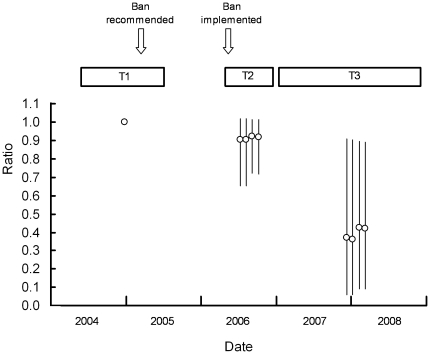
Changes in the expected rate of decline of the oriental white-backed vulture population in India.Circles show the estimated rate of population decline, as a ratio relative to that determined from the T1 survey results in 2004 – 2005. Values are plotted at the mean sampling time for each of the surveys. Horizontal rectangles show the duration of the period covered by the sample collection for each survey. Vertical lines show 95% confidence limits for the ratios. Each of the four adjacent points in a set represents the result for a combination of assumptions (from left to right: F = 2, S0 = 0.90; F = 2, S0 = 0.97; F = 3, S0 = 0.90; F = 3, S0 = 0.97). Arrows show the timing of the recommendation by the National Board for Wildlife for a ban on the veterinary use of diclofenac and the withdrawal by the Drug Controller General of manufacturing licences for veterinary formulations of the drug.